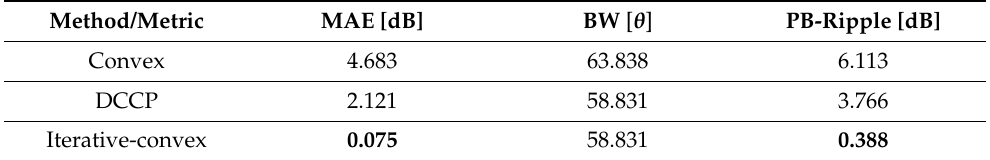
Table 2. Measurements of the beamwidth (BW), the passband-ripple (PB-ripple), and the MAE between the desired rectangular beampattern and the optimized beampatterns measured in the main lobe interval with BW = 50 ◦ . The best measurement values achieved are marked out in bold.